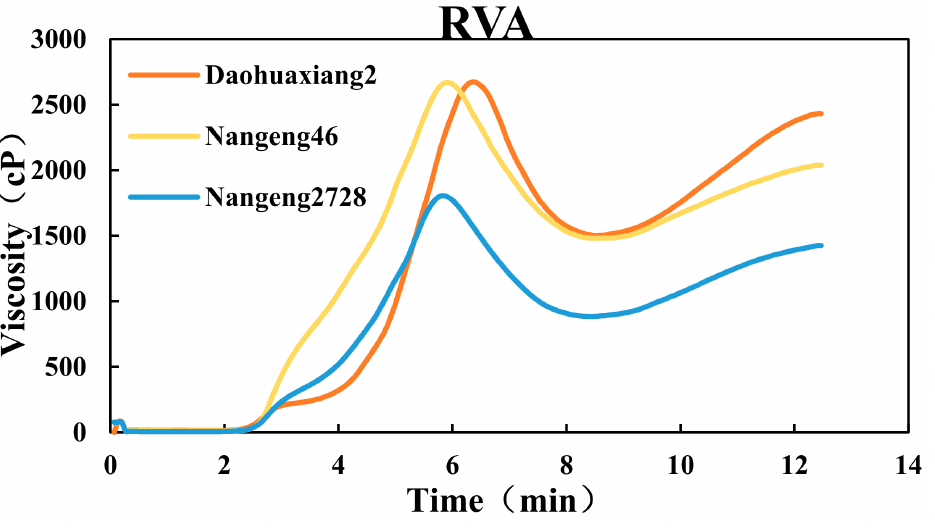
Figure 1. RVA profile of different japonica rice. Table 2. Differences of rice flour pasting properties among different japonica